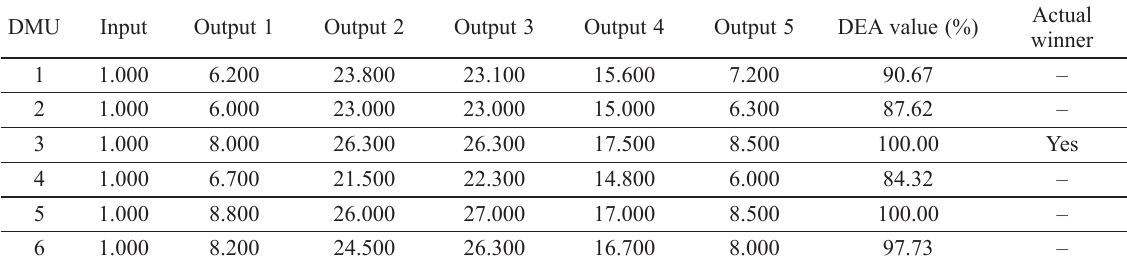
Table 2. DEA evaluation results of case project 1 DMU